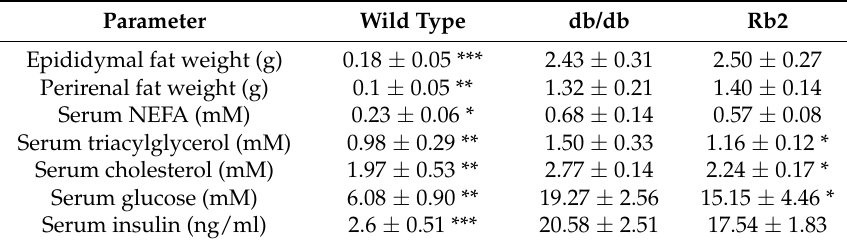
Table 1. Fat weight and serum biochemical